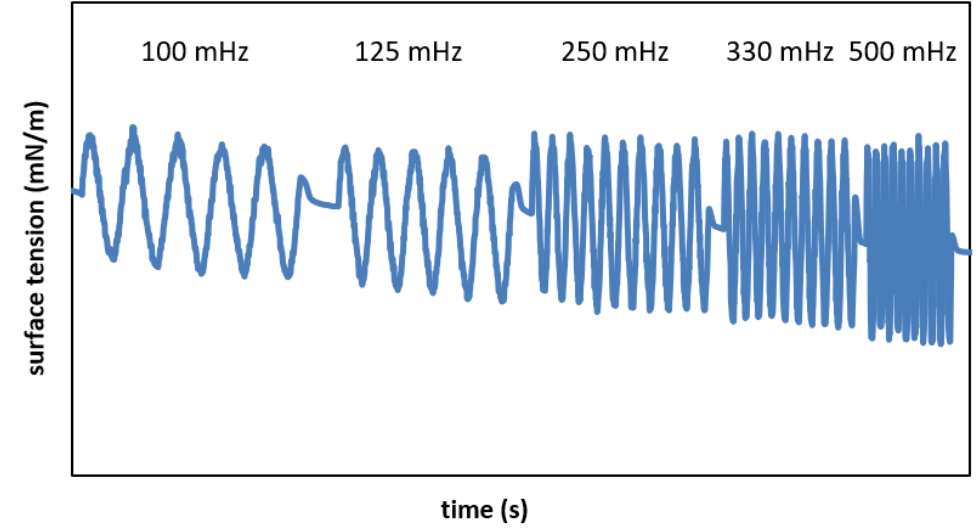
Figure 1. The dynamic surface tension data during surface oscillations at frequencies f = 100, 125, 250, 330, and 500 mHz.